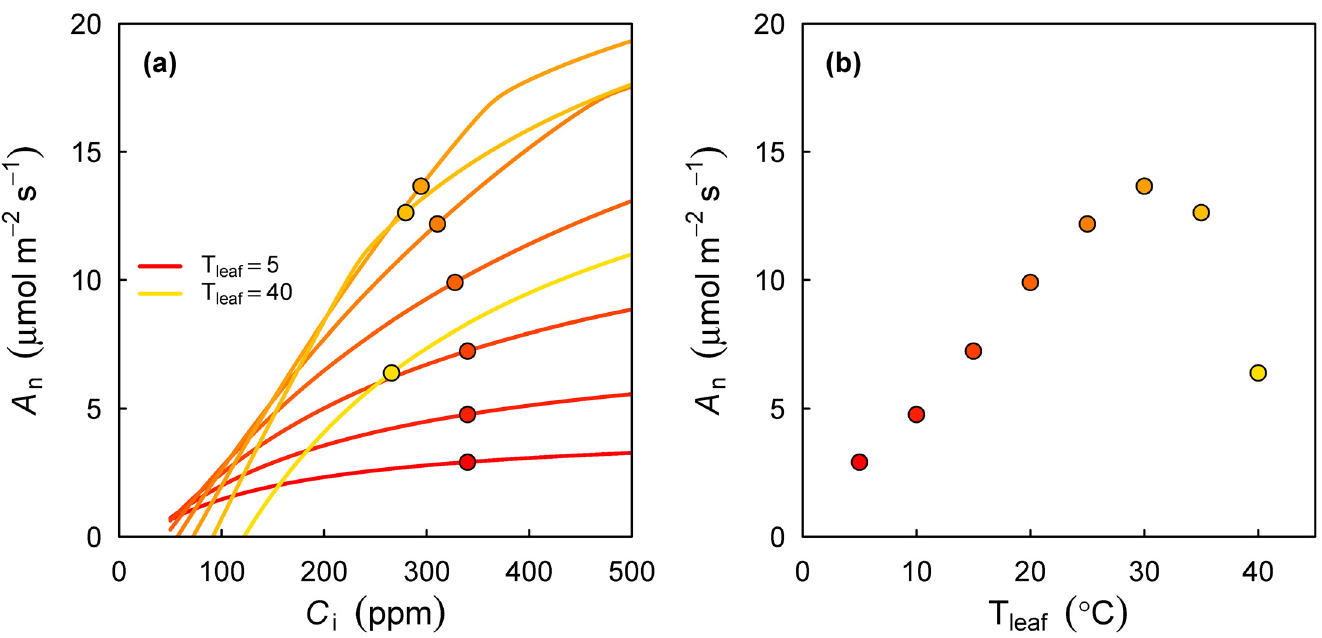
Fig 3. Response of A n and C i to combined changes in T leaf and D. (A) Lines are A-C i curves simulated at a range of values for T leaf . Symbols are the solutions of the coupled leaf gas exchange model, while also taking into account the correlation between D and T leaf (based on an empirical relationship [35]: D = 0.000605 * T air2.39 ). Note that as T leaf and D increase, C i decreases. (B) The corresponding temperature optimum of A n . Symbols are the same as in panel (A) but plotted against T leaf .